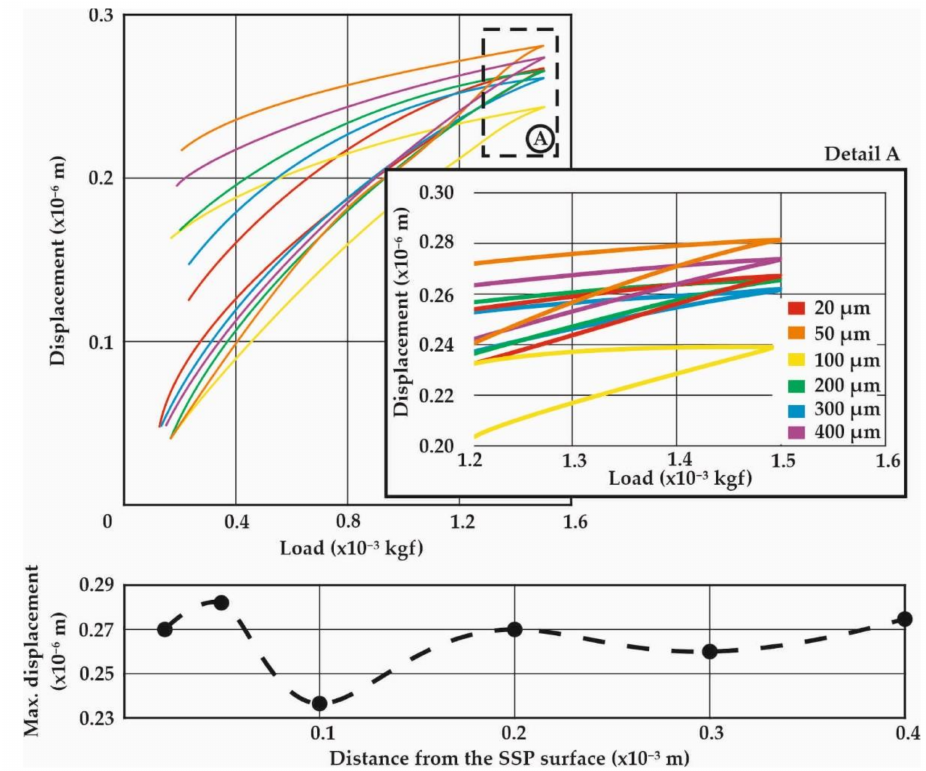
Figure 9. Nanoindentation load-displacement diagrams for the HTT+SSP leaf spring specimens at characteristic distances from the surface.